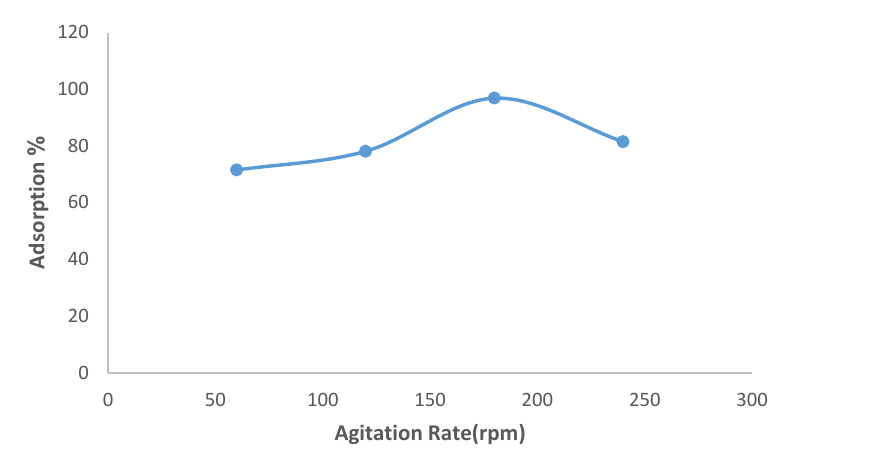
Figure 6. Effect of stirring speed (rpm) on the adsorption of methyl orange dye at a concentration of 20 mg /L